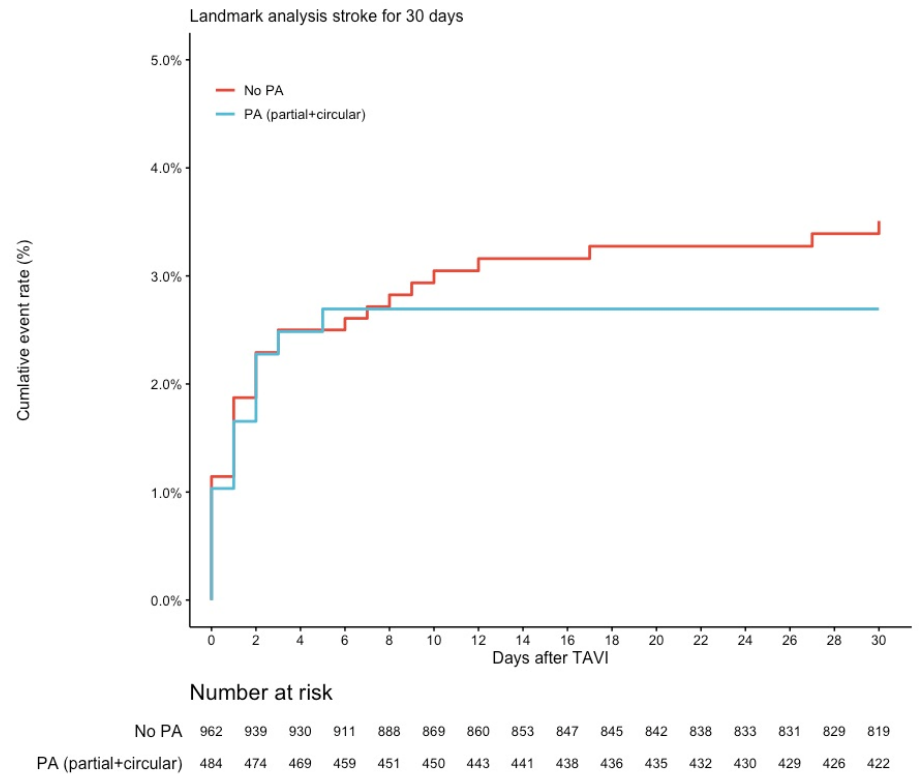
Figure 2. Kaplan–Meier Curve for mortality up to 30 days. Abbreviation: PA, porcelain aorta. 1 Lost to follow-up at 30 days: n = 30 (2.0%).